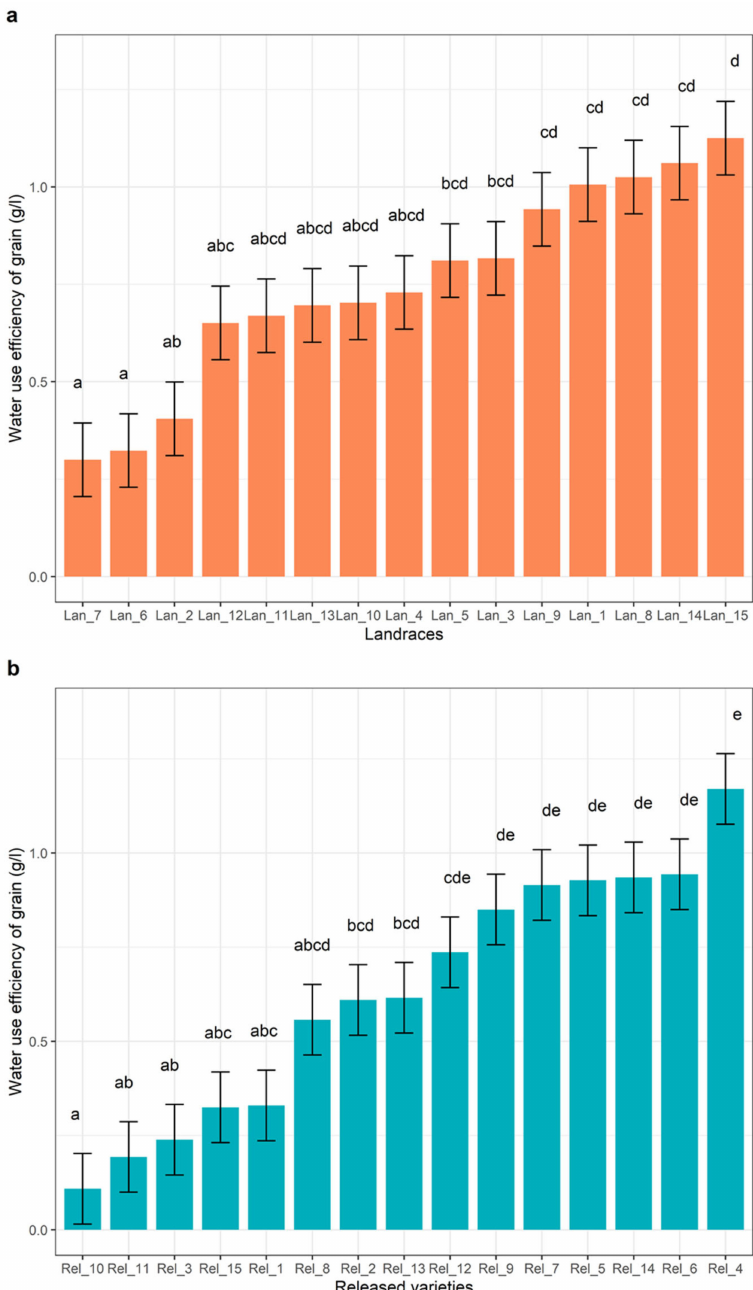
Figure 4. Mean response of landrace ( a ) and released cultivars ( b ) regarding the water-use efficiency of grains (WUE_G, g L − 1 ). The letters indicate the significant level between genotypes/cultivars. Mean values sharing a letter are not significantly